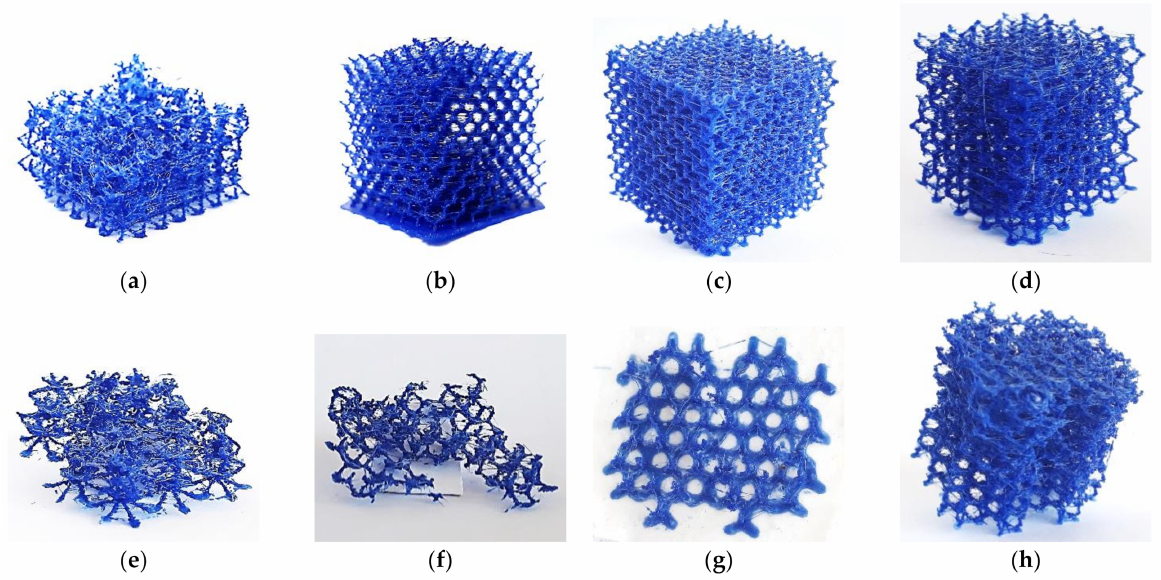
Figure 2. 3D printed lattice structures (scale 1:1, Ender 3, PLA): ( a ) cube vertex centroid; ( b ) cubic diamond; ( c ) cubic fluorid; ( d ) tet vertex centroid; ( e ) hex prism vertex; ( f ) tet oct vertex centroid; ( g ) hex prism diamond; ( h ) hex prism laves phase. Dimensions of specimens are reported in Table